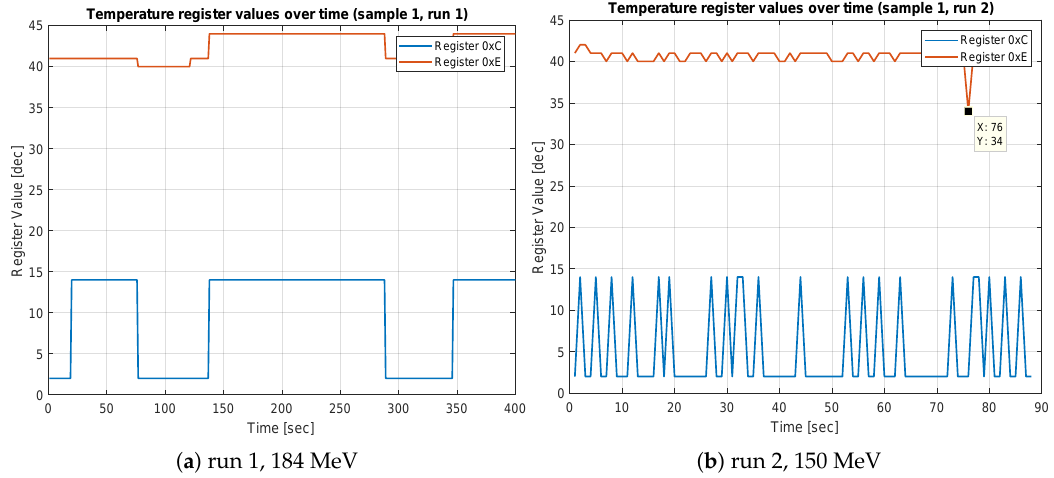
Figure 12. Temperature register values nominal ( a ); and with bit-flip event ( b ) (Sample 1, Runs 1 and